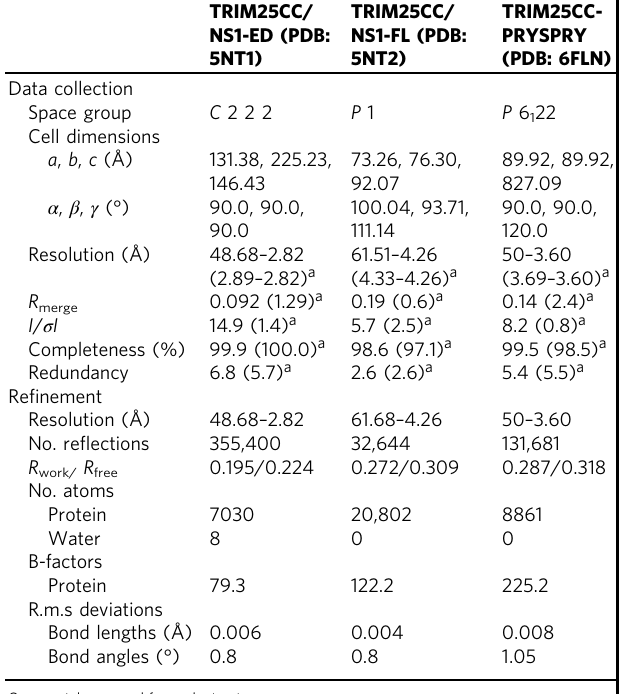
Table 1 Data collection and re fi nement